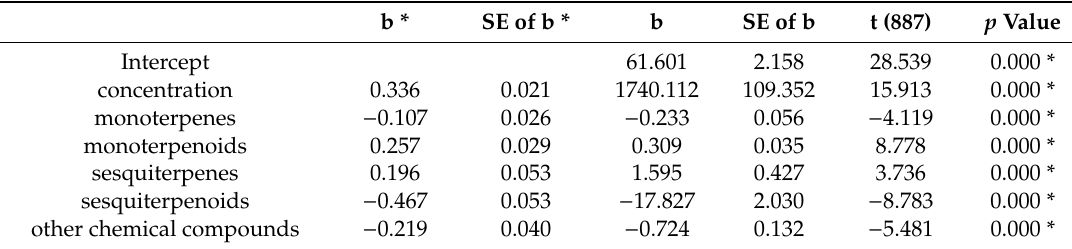
Table 11. Result of multiple regression.